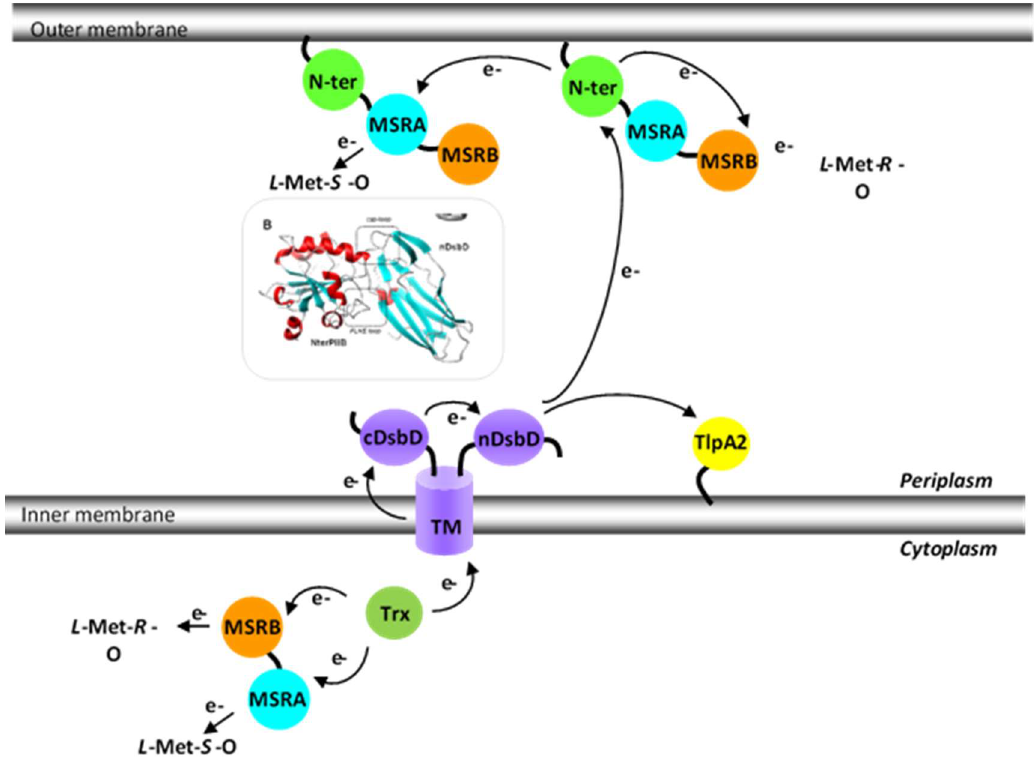
Figure 5. N. meningitidis Met-O reducing pathways. The electrons used by the MSR domains of PilB originate from the cytoplasmic Trx and are furnished either directly to the domains (in the case of the cytoplasmic PilB AB ) or via the intermediary of the three domains of disulfide-bond formation (Dsb) D (transmembrane TM, cDsbD and finally nDsbD) and the N -ter domain (in the case of periplasmic PilB). The N -ter/nDsdD model is also represented.